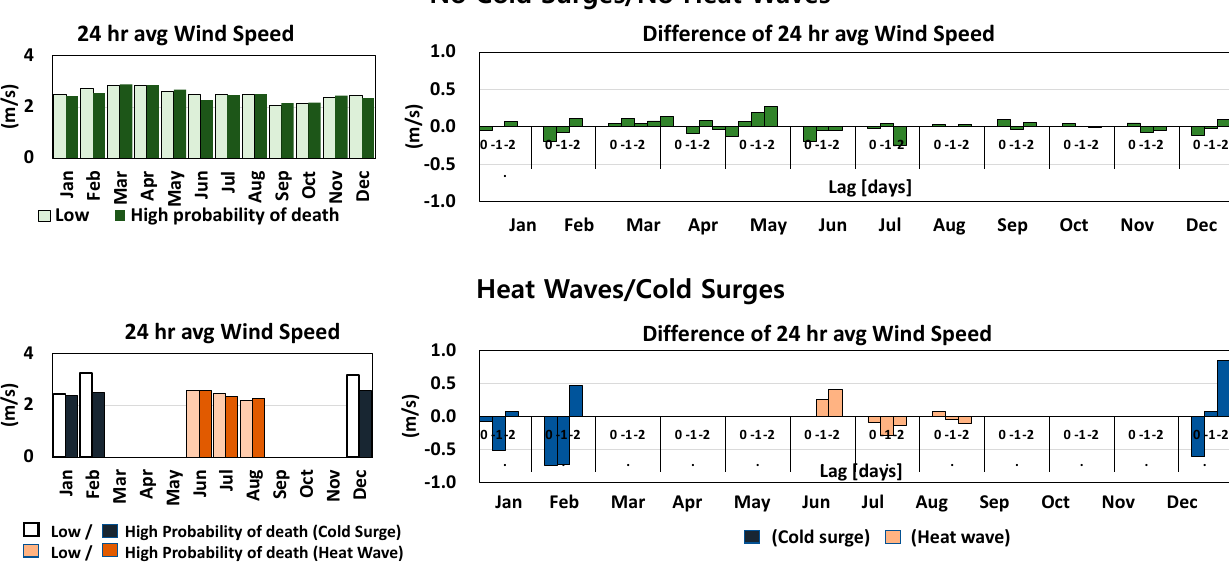
Figure 14. Comparison of monthly average wind speed on days of high and low probability of death, and the differences in wind speed (wind speed (high probability of death) –wind speed (low probability of death) ) from zero to two days before death.